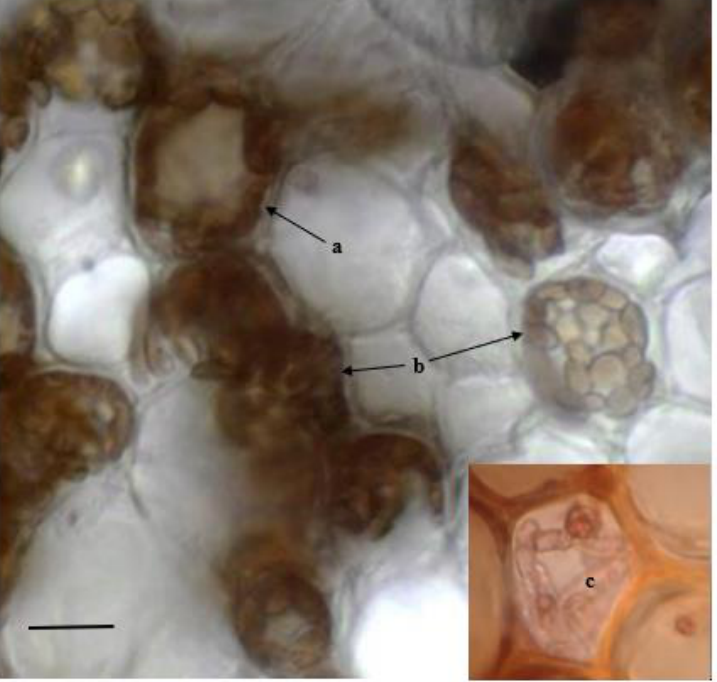
Figure 2. Radial section of P. oceanica root: intracellular fungal colonization by melanized and septate hyphae (a), brown microsclerotia (b) and young red-stained intracellular hyphae (c). Bar = 20 µm. Sections of the rhizomes from the three sites showed both melanized and grayish hyphae surrounding and enveloping the host cells, from the thin cuticle to the central stele. In the stained sections, the hyphae were coloured red. In a few cases, fungal propa- gative structures were observed, both outside and inside the detected organs (Figure 3).